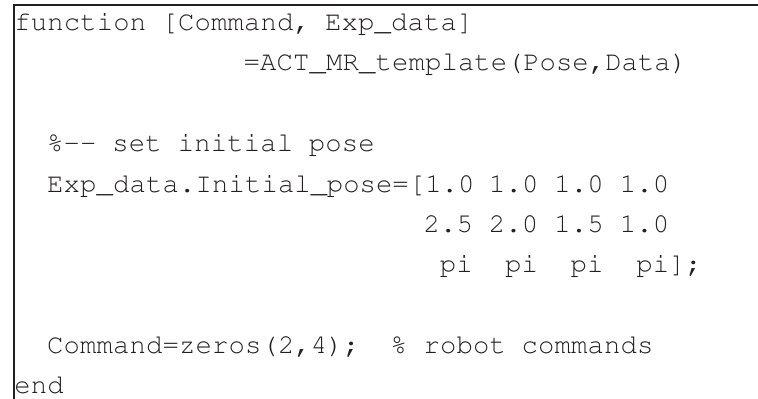
Figure 5. Template function for user-defined controllers.